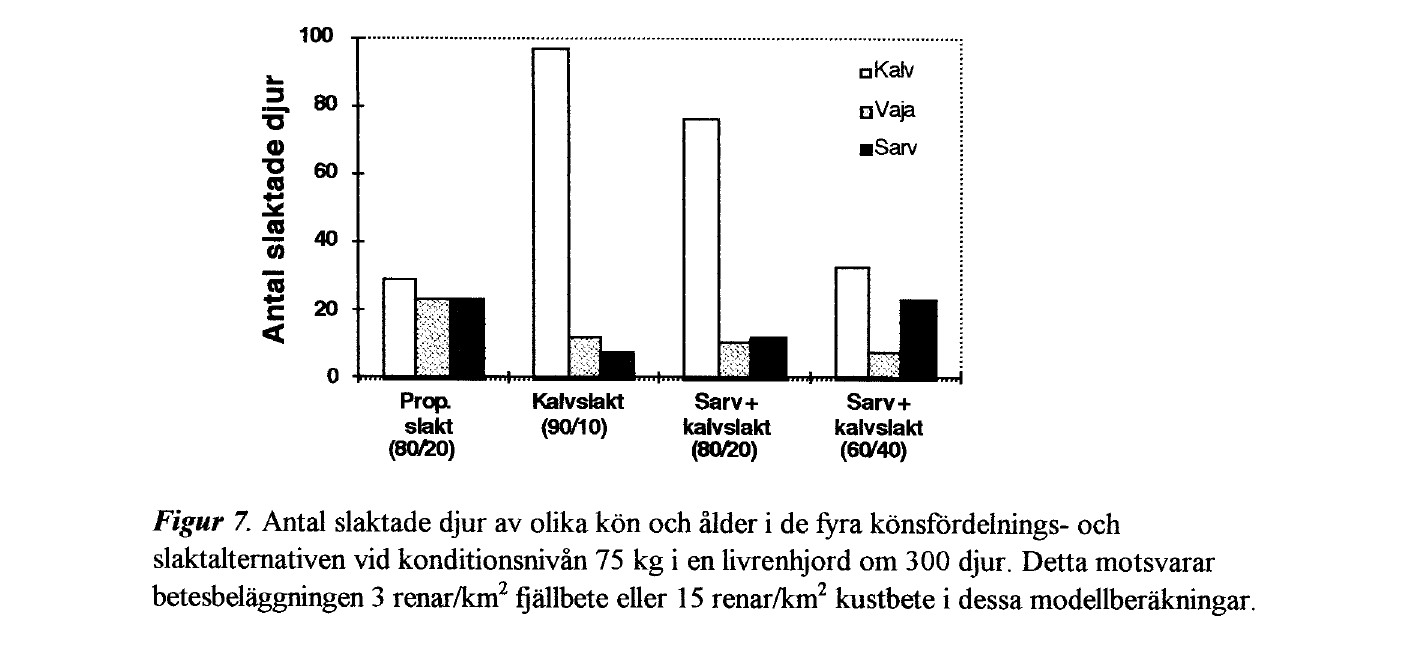
Urval ger förbättringar på längre sikt Den tredje optimeringsmöjligheten är att förbättra djurmaterialets kvalitet genom urval med hjälp av produktionsdata. De huvudsakliga urvalsmöjligheterna är att välja kalv efter egen vikt eller efter modems produktion, samt att välja vilka vajor som skall behållas ytterligare ett år på basis av deras kalvproduktion. Urvalet är en åtgård, som gradvis leder till ett allt bättre djurmaterial enligt "ränat på ränta"-principen. Urval fbrutsätter dock sannolikt en god betesanpassning for att förbättringen i djurmaterialets egenskaper skall komma till synligt uttryck. Dessutm, ju bättre kalvprocenten är, desto större möjligheter har man att göra urval genom att man har fler djur att välja mellan vid rekryteringen av livdjur, och desto bättre är de djur som behålls i